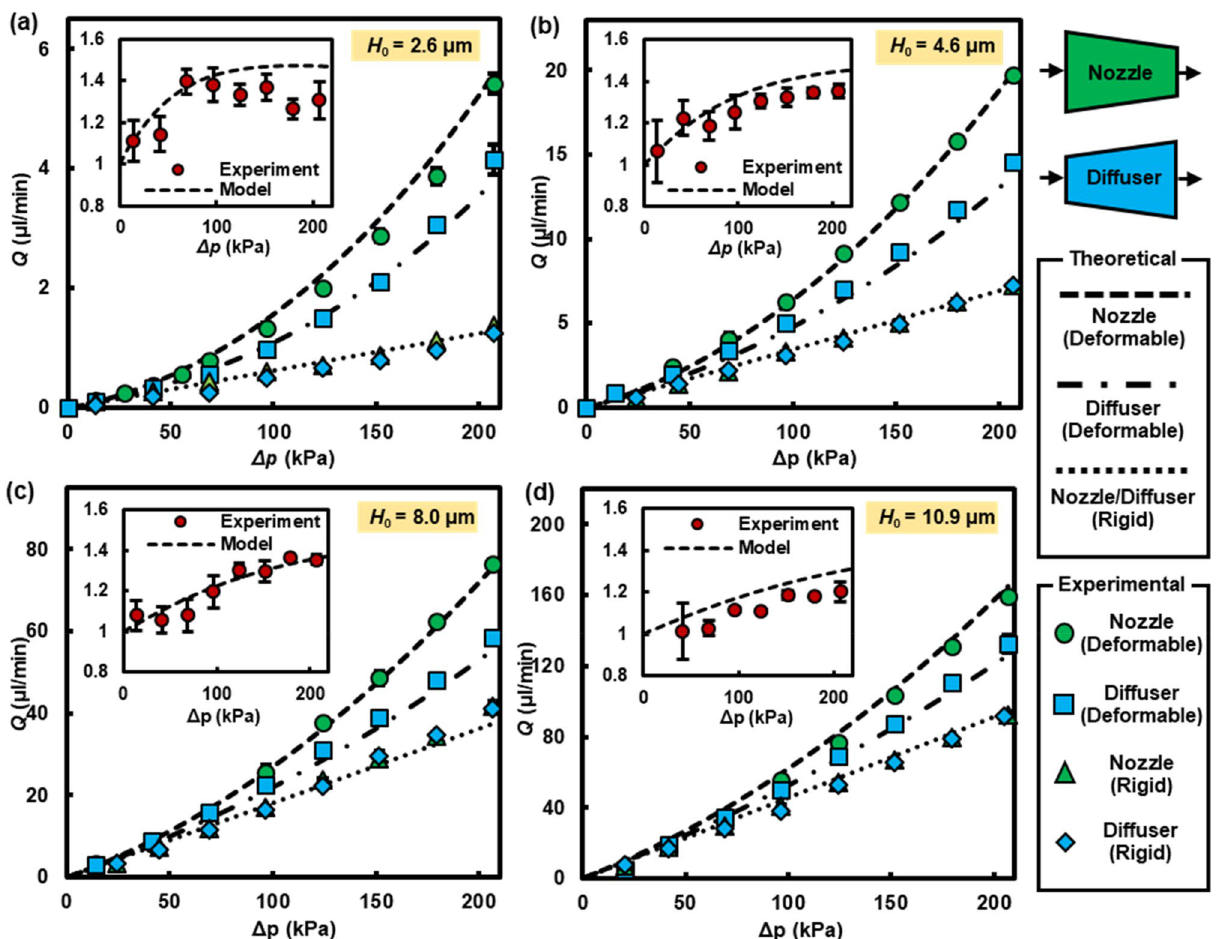
Figure 2. Volumetric flow rates, Q , of DI water as a function of pressure difference, (cid:31) p , across deformable (or flexible) and rigid nozzle/diffuser microchannels (with the widths of 1 and 2 mm and length of 22.9 mm) 0.2 µ m , ( b ) 4.6 0.2 µ m , ( c ) 8.0 0.3 µ m , and ( d ) for various original channel heights of H 0 ( a ) 2.6 = ± ± ± 0.3 µ m . The dashed, dash-dotted, and dotted lines show the results obtained from the fluid–solid coupled 10 .9 ± model for deformable nozzle, deformable diffuser, and rigid nozzle/diffuser, respectively. The inset graphs show the rectification ratio, η , as a function of (cid:31) p for each deformable nozzle/diffuser microchannel. The error bars were averaged over three runs and may not be visible if they are smaller than the marker’s